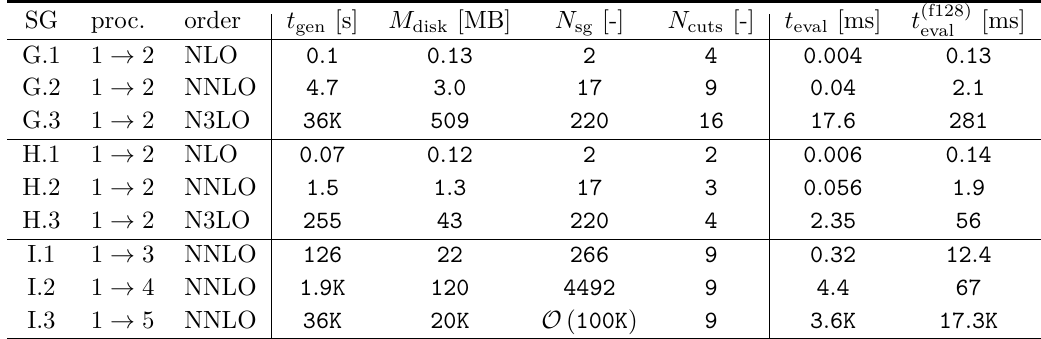
Table 7. Performance for characteristic supergraphs of figure 15 corresponding to N k LO corrections for 1 → N × X processes, with k = 1 , 2 , 3 and N = 1 , 2 , 3 . See text for details.